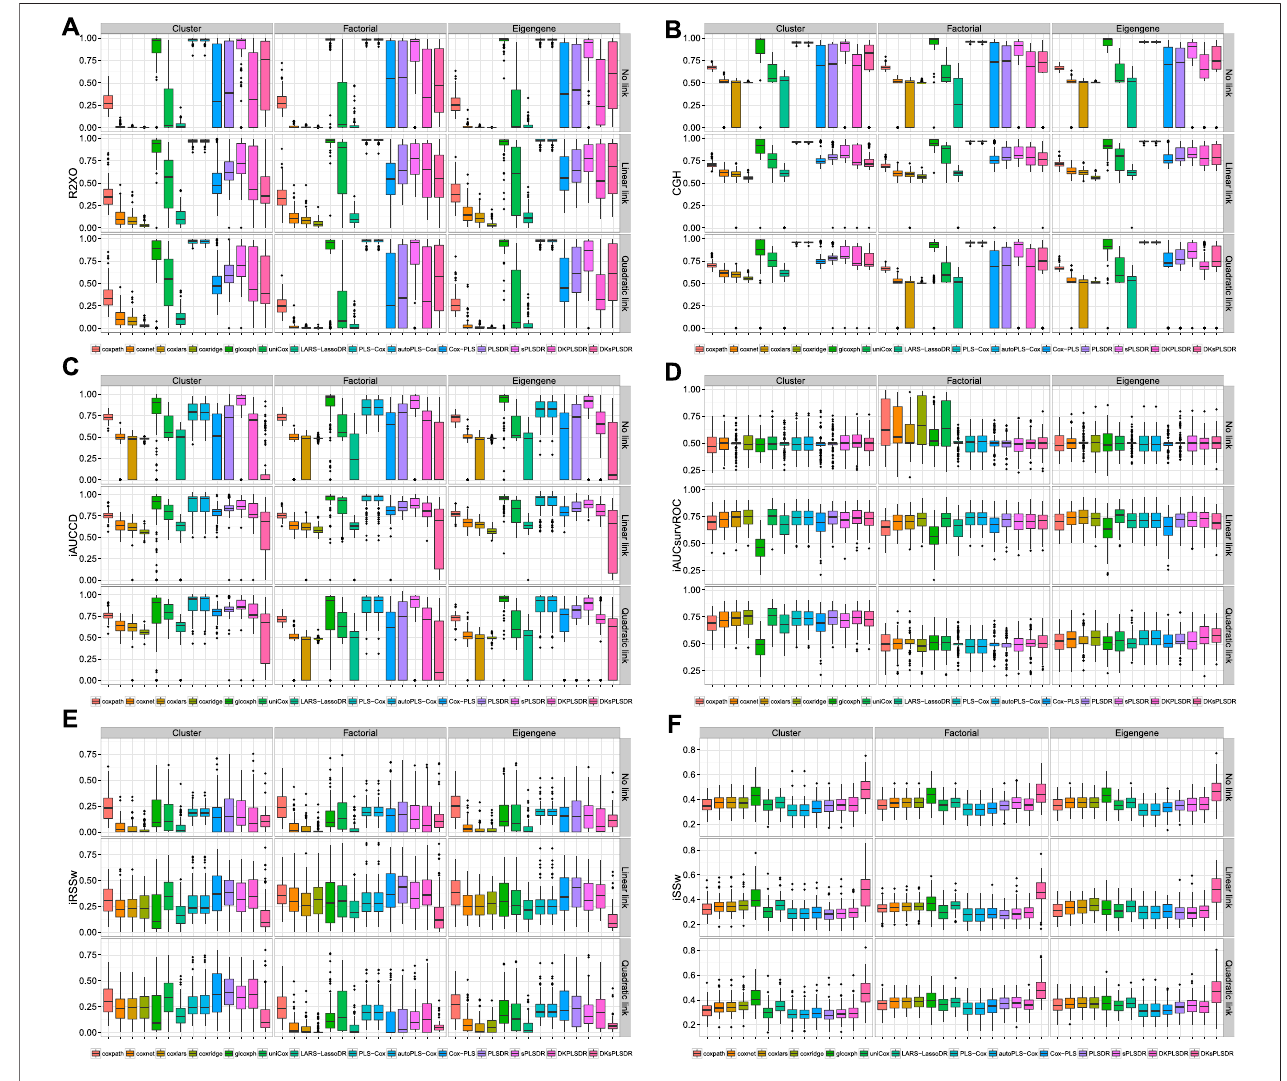
FIGURE 8 | Model selected by iAUCsurvROC CV, panel by performance measure. panel (A) : R2XO measure. panel (B) : GHCI measure. panel (C) : iAUCCD measure. panel (D) : iAUCSurvROC measure. panel (E) : iRSSw measure. panel (F) : iSSw measure.